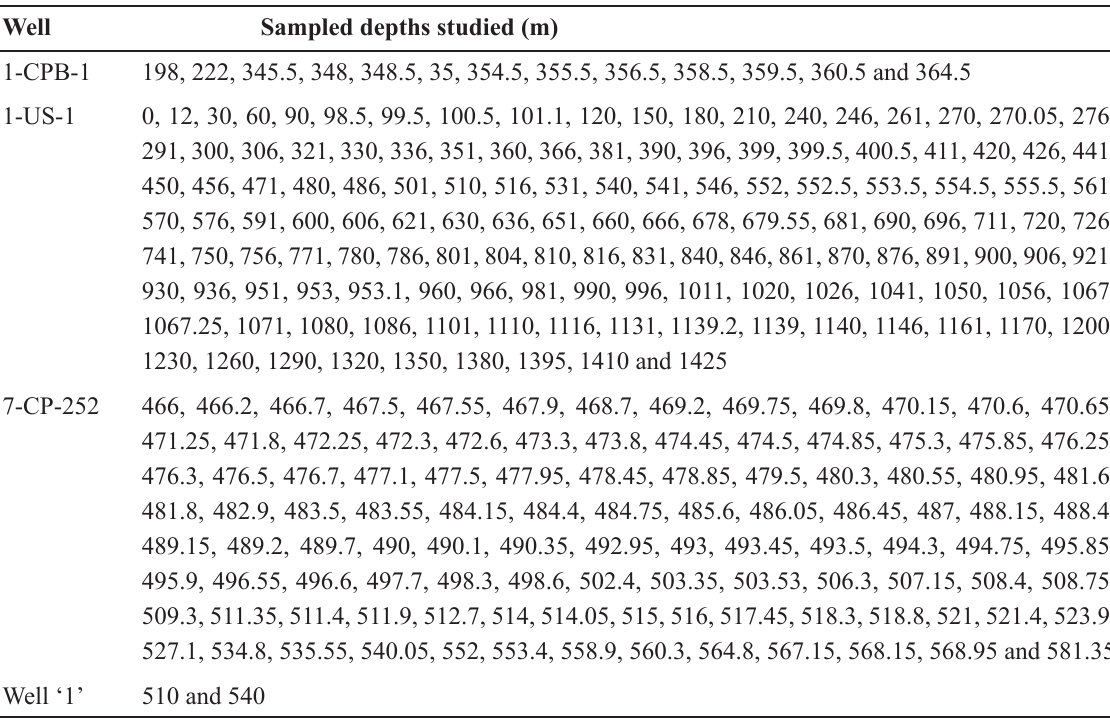
Table 1. Sampled depths from wells ceded by Petrobras S.A. studied in the present work.